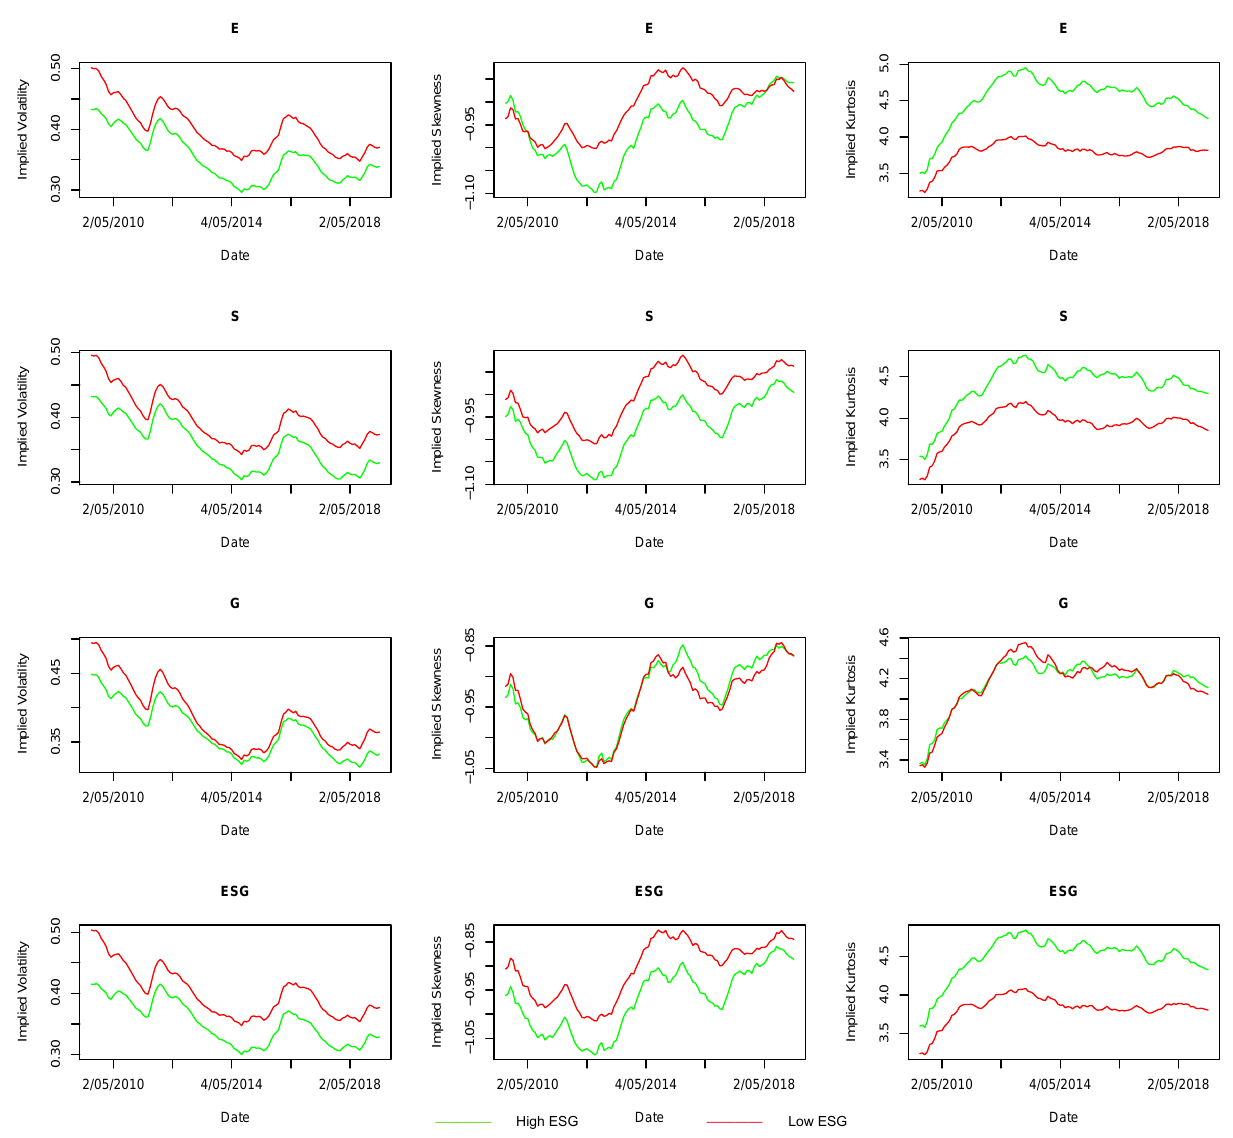
Figure 1. Average implied moments of companies in high and low ESG rating